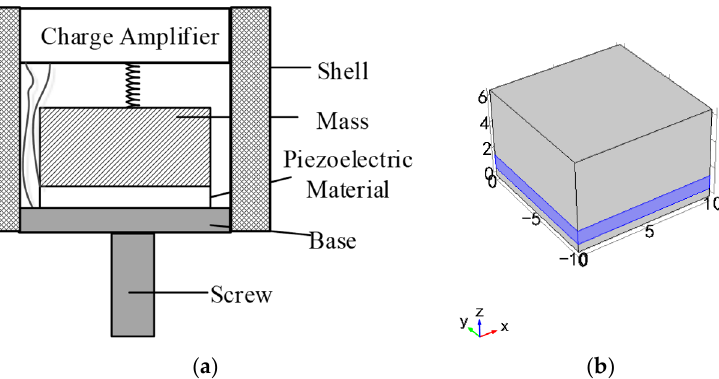
Figure 8. ( a ) The schematic of the central compressed model; ( b ) The central compressed model.